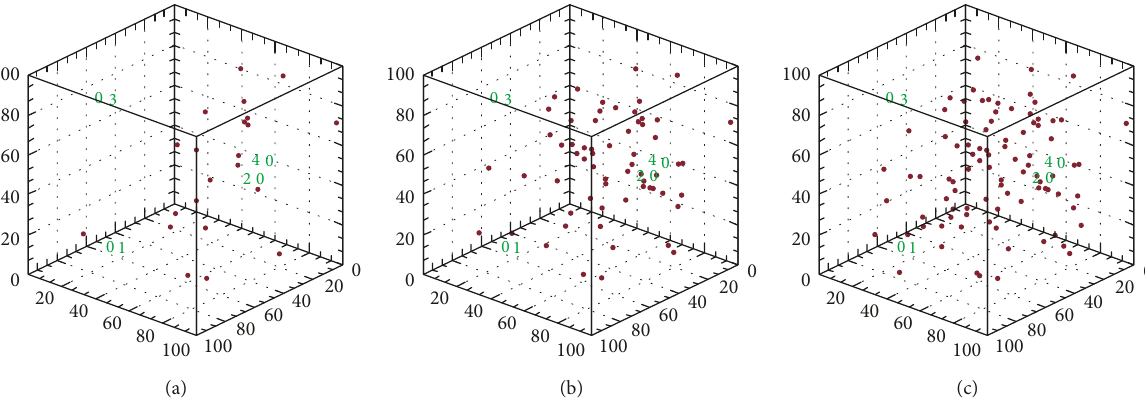
Figure 10: Characteristics of the AE events with 30% waste concrete substitution under uniaxial loading. (a–c) correspond to 0- σ and σ c - σ d of the stress stage in Figure 6.